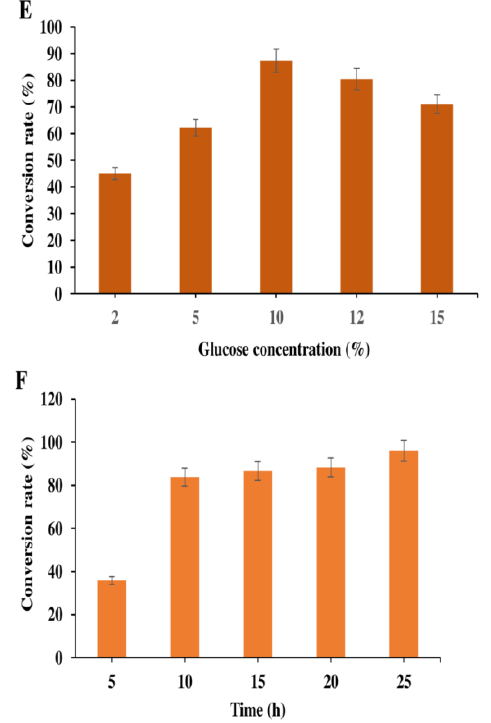
Figure 4. Determination of optimum culture conditions using butyl-4-aminobenzoate as substrate. ( A ) Conversion rate of butyl-4-aminobenzoate with different IPTG concentrations to determine optimum IPTG concentration for induction, after 10 h in 30 °C; the optimum IPTG concentration is 0.5 mM. ( B ) IPTG induction time length at different times; the optimum IPTG induction time is 10 h. ( C ) Conversion rate of butyl-4-aminobenzoate at different temperatures using the optimum IPTG concentration of 0.5 mM. ( D ) The conversion rate of butyl-4-aminobenzoate using different substrate concentrations; the optimum concentration is 2 mM. ( E ) Conversion rate using different concentrations of glucose with the already determined conditions; the optimum glucose concentration is 10%. ( F ) Conversion rate of butyl-4-aminobenzoate at a 5 h time interval using the optimum IPTG concentration of 0.5 mM and optimum temperature of 37 °C, 2 mM substrate and 10% glucose. (Error bars show the standard deviation of three distinct experiments).